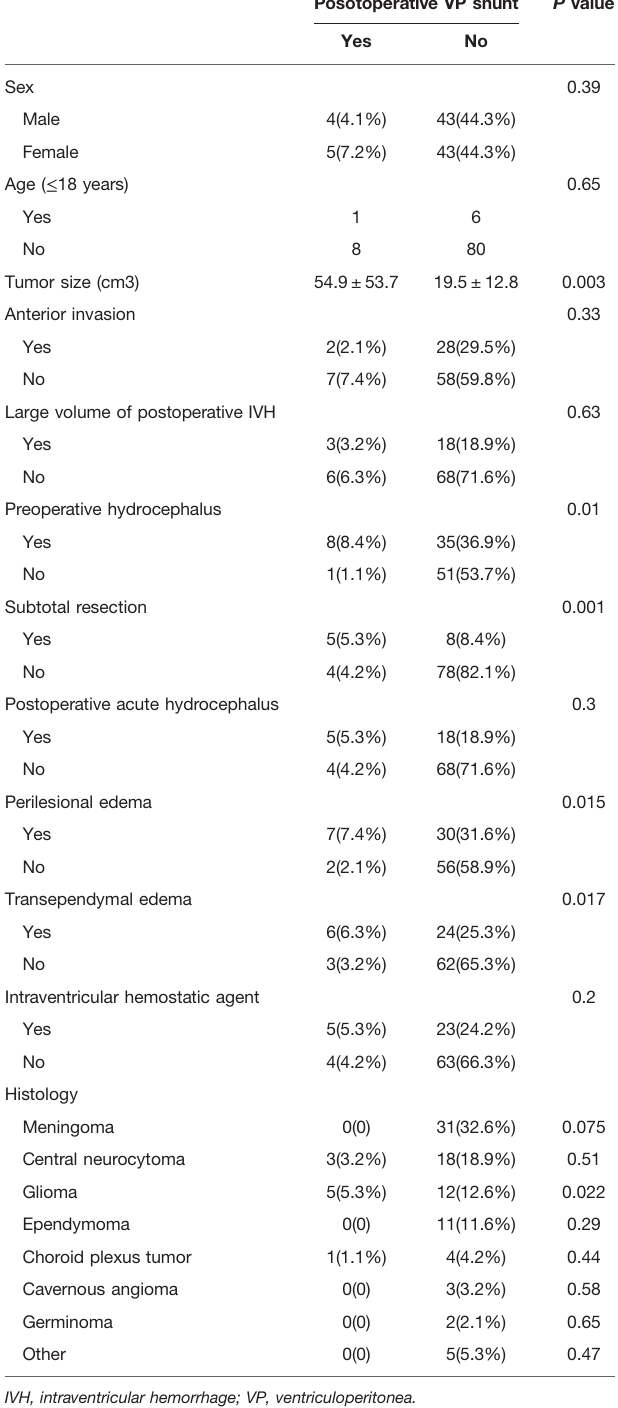
TABLE 4 | Summary of the factors with a postoperative VP shunt. TABLE 5 | Multivariate analysis of the association between a postoperative VP shunt and